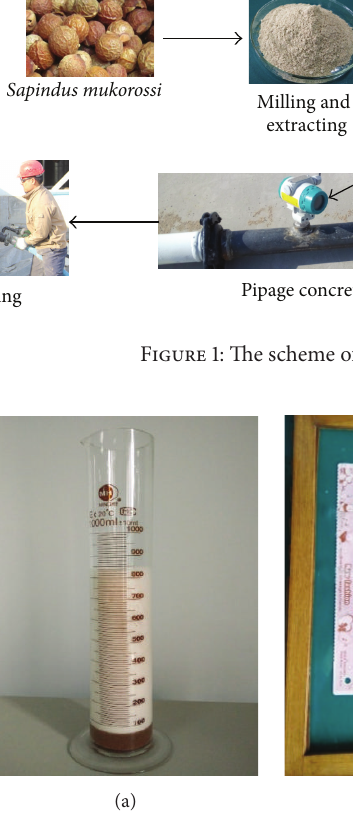
Figure 2: Tests of foaming volume (a) and maximal foam diameter